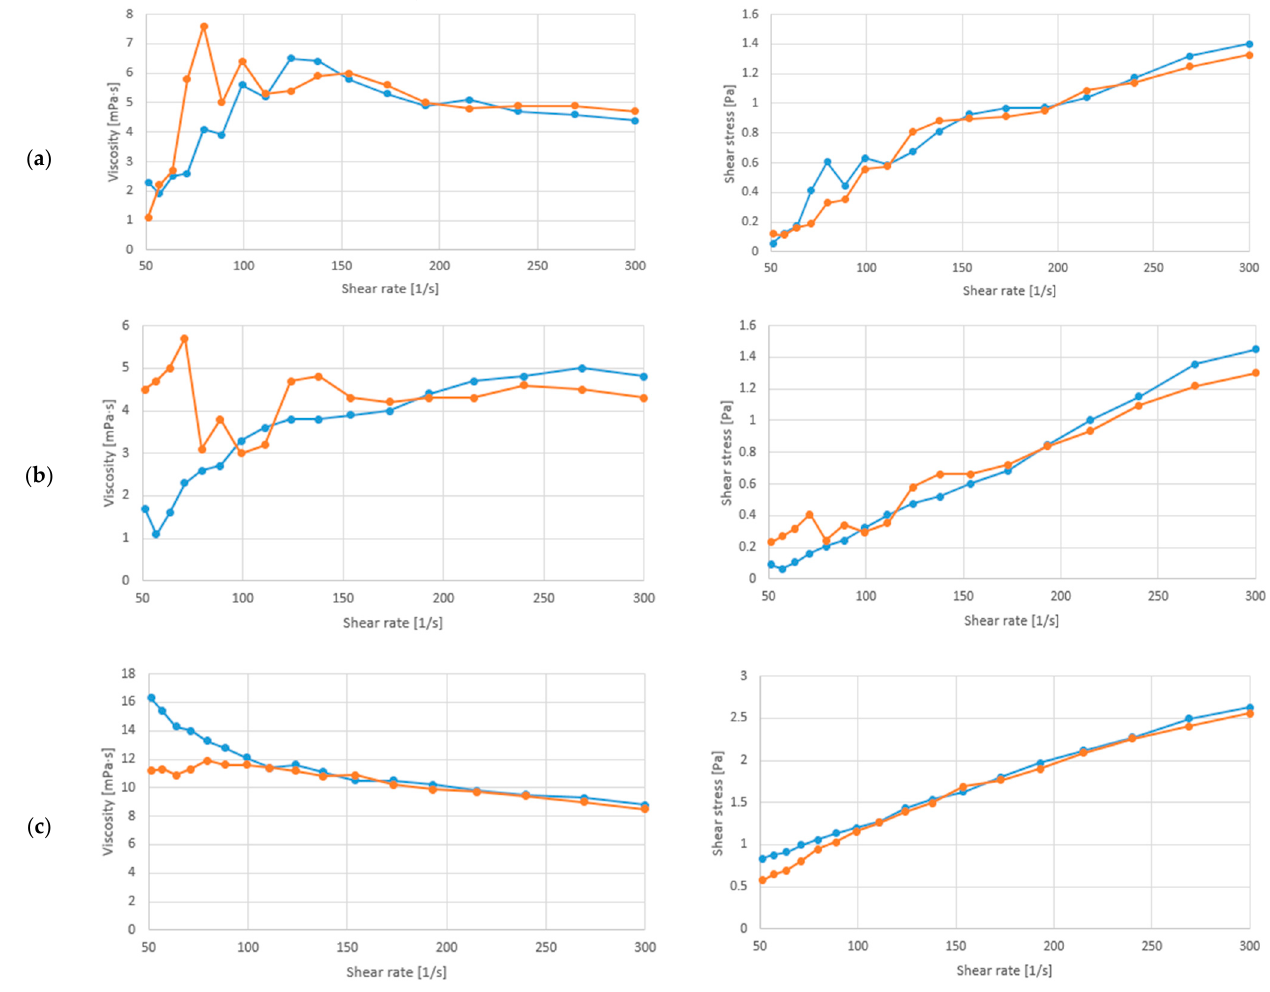
Figure 3. Relationship between viscosity/shear stress and shear rate at 20 °C of the samples with ( a ) Soy drink + L. fermentum, ( b ) Soy drink + L. fermentum + Xylitol , ( c ) Soy drink + L. fermentum + C. vulgaris + Xylitol (experiments effectuated in duplicate red and blue line).